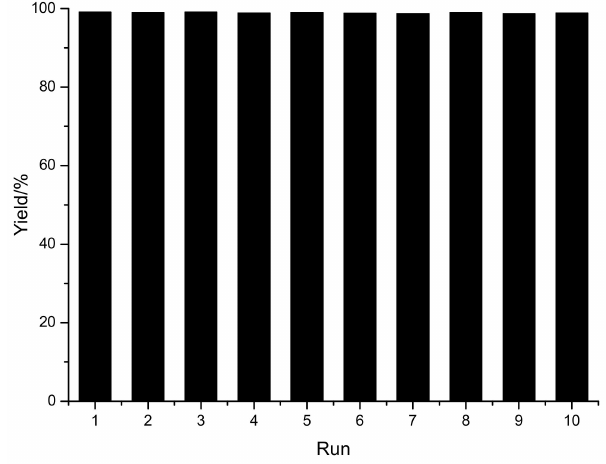
Figure 5. The recycled activity of the magnetic carbon microtube-based solid acid.